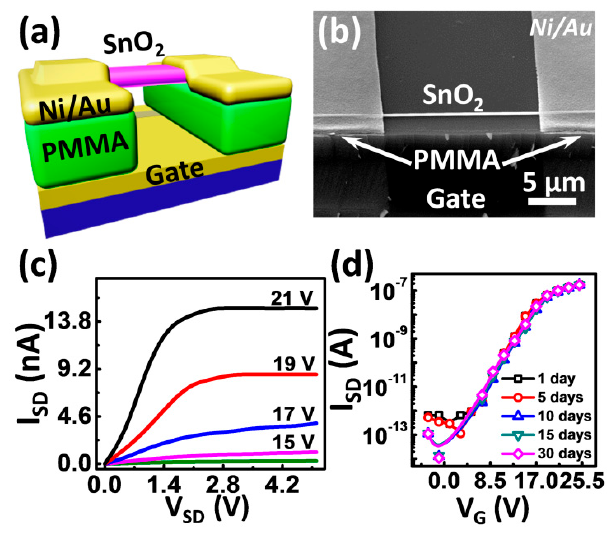
Figure 2. ( a ) the schematic representation of the gas-dielectric SnO 2 nanobelt FETs; ( b ) the representative SEM image of the device; ( c , d ) output and transfer curves of the FET in air at room temperature. All the transfer curves measured in 30 days are overlapped well, which shows the good stability of the device.